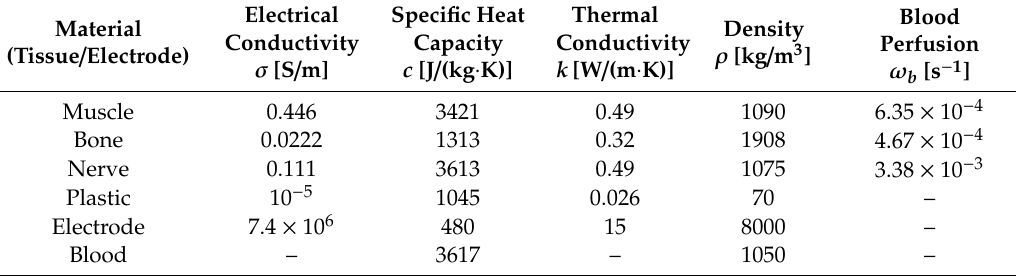
Table 1. Thermo-electric and biophysical properties of di ff erent materials considered in this